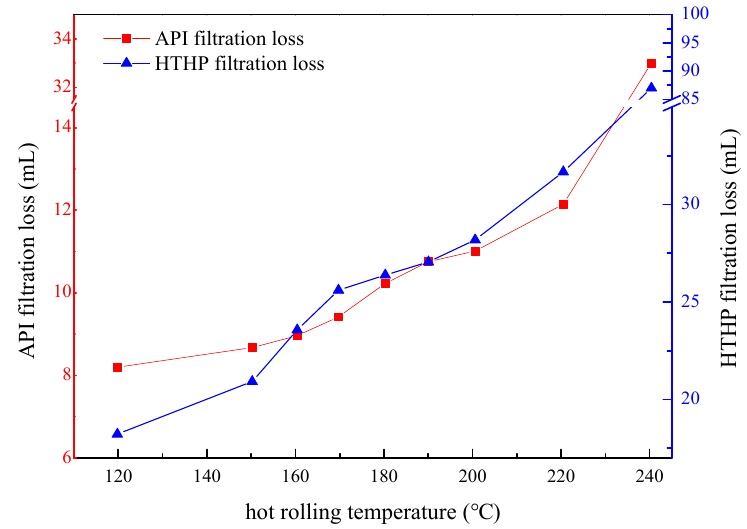
Figure 11. Filtration loss after aging at different temperatures.